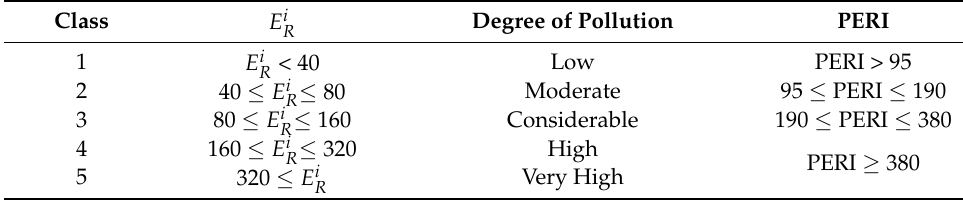
Table 1. Classification of potential ecological risk for a single regulator and PERI.